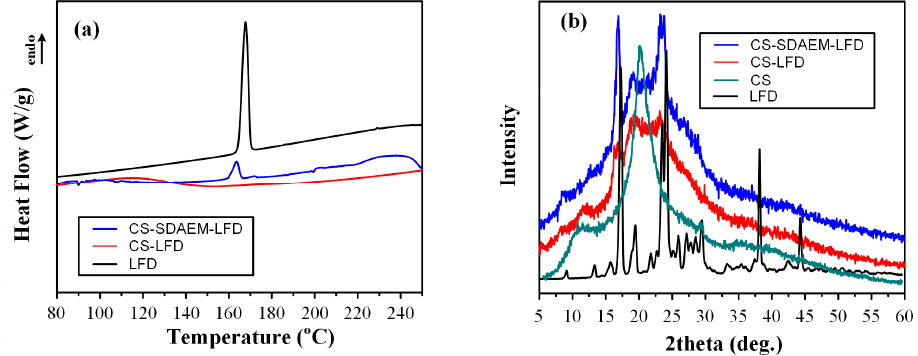
Figure 5. DSC thermograms ( a ) and pXRD diffractograms ( b ) of LFD loaded CS and CS-SDAEM NPs.